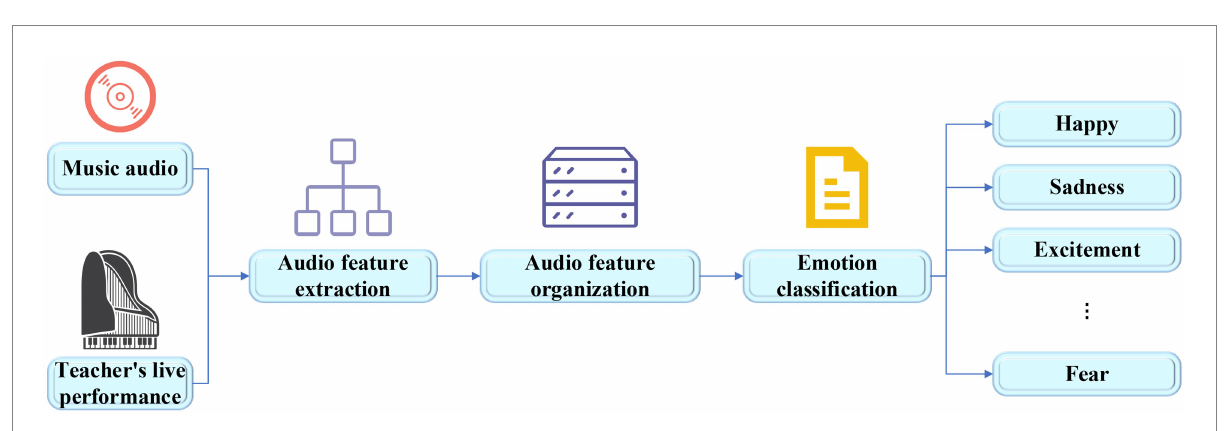
FIGURE 11 Flow chart of music emotion classification.